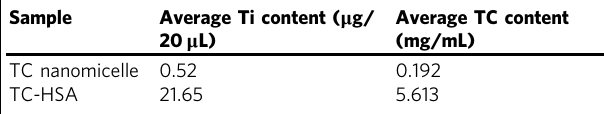
Table 2 Metal (Ti) and TC content in nanomicelles and HSA